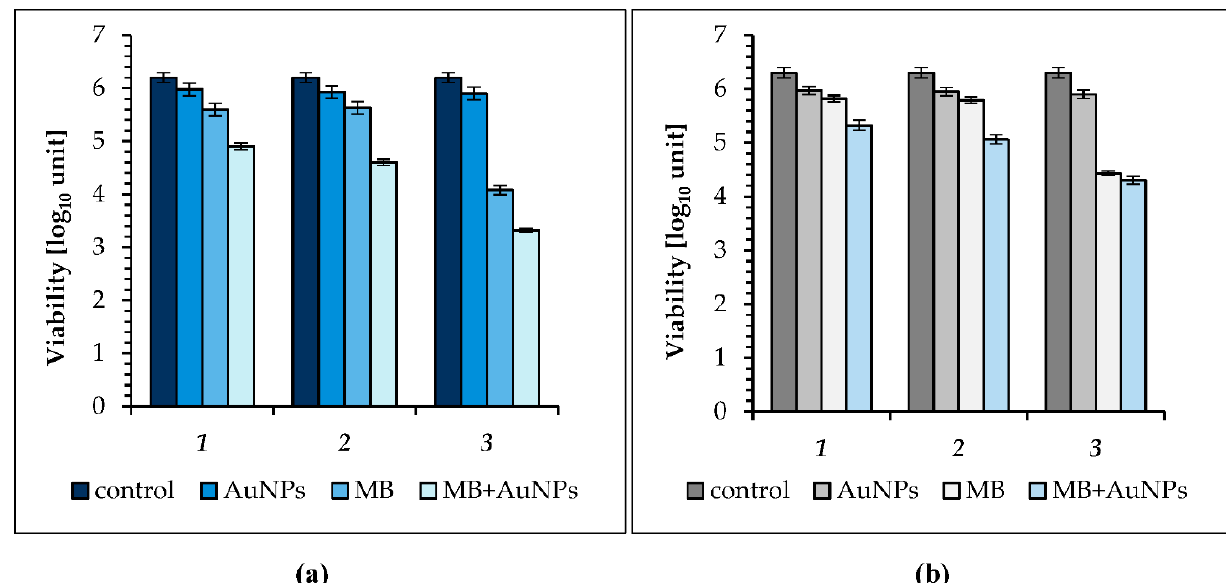
Figure 2. ( a ) Effect of AuNPs (gold nanoparticles), MB (methylene blue) and the MB + AuNP (methylene blue-gold nanoparticle mixture) on viability of: S. aureus following incubation in the dark: ( 1 ) exposure to LED light for 5 min (energy fluence was 0.75 J cm − 2 ); ( 2 ) 15 min (energy fluence was 2.25 J cm − 2 ); ( 3 ) 30 min (energy fluence was 4.5 J cm − 2 ). ( b ) E. coli following incubation in the dark: ( 1 ) exposure to LED light for 5 min (energy fluence was 0.75 J cm − 2 ); ( 2 ) 15 min (energy fluence was 2.25 J cm − 2 ); ( 3 ) 30 min (energy fluence was 4.5 J cm − 2 ); (in all groups p < 0.05); the control is the initial concentration of bacteria in suspensions kept in the dark.